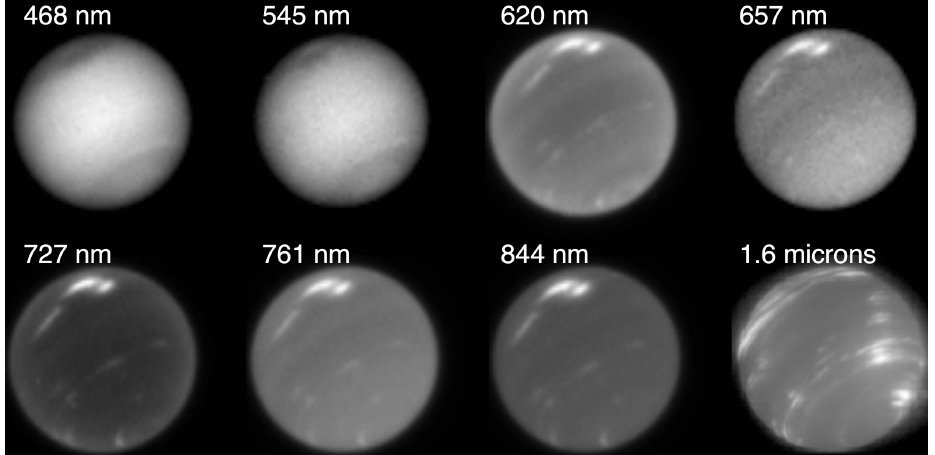
Figure 10. Neptune’s appearance at visible and near IR wavelengths. November 2018 Hubble and August 2018 Keck data [118] show Neptune’s cloud band variations with wavelength. Neptune’s 2018 northern great dark spot is visible at shorter wavelengths to the upper left, while companion clouds are brighter at longer